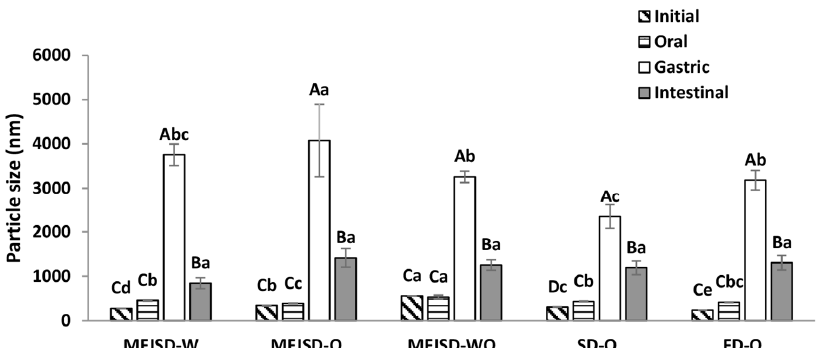
Figure 5. The particle size changes of the microcapsules after in vitro digestion. MFJSD-W, MFJSD-O, and MFJSD-WO: microcapsules produced by microfluidic-jet spray drying, using WPI only, OSA only, and a combination of WPI/OSA (50/50 w / w ) as wall materials, respectively; SD-O: microcapsules produced by two-fluid nozzle spray drying, using OSA only as wall material; FD-O: microcapsules produced by freeze-drying, using OSA only as wall material; WPI: whey protein isolate; OSA: octenylsuccinic anhydride modified starch. The lowercase letters indicate significant difference in different samples with the same digestion phase ( p < 0.05); the uppercase letters indicate significant difference in same sample ( p < 0.05).